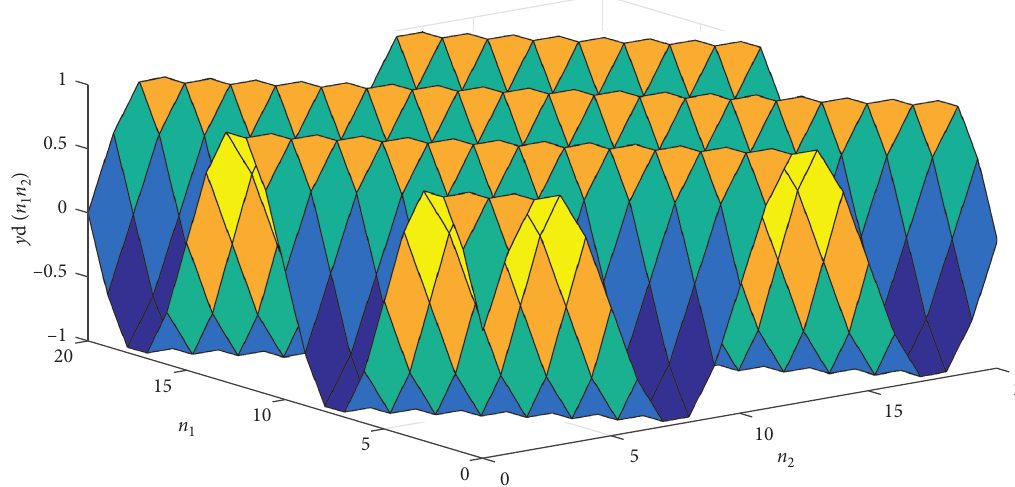
Figure 1: The desired surface trajectory y